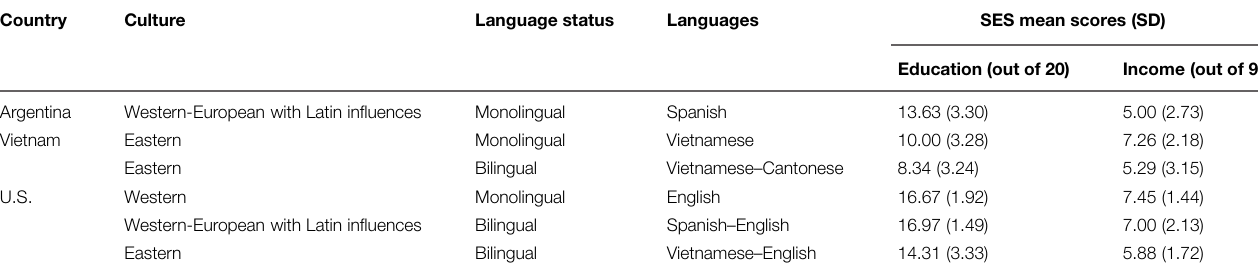
TABLE 3 | Socio-economic status (SES) scores.